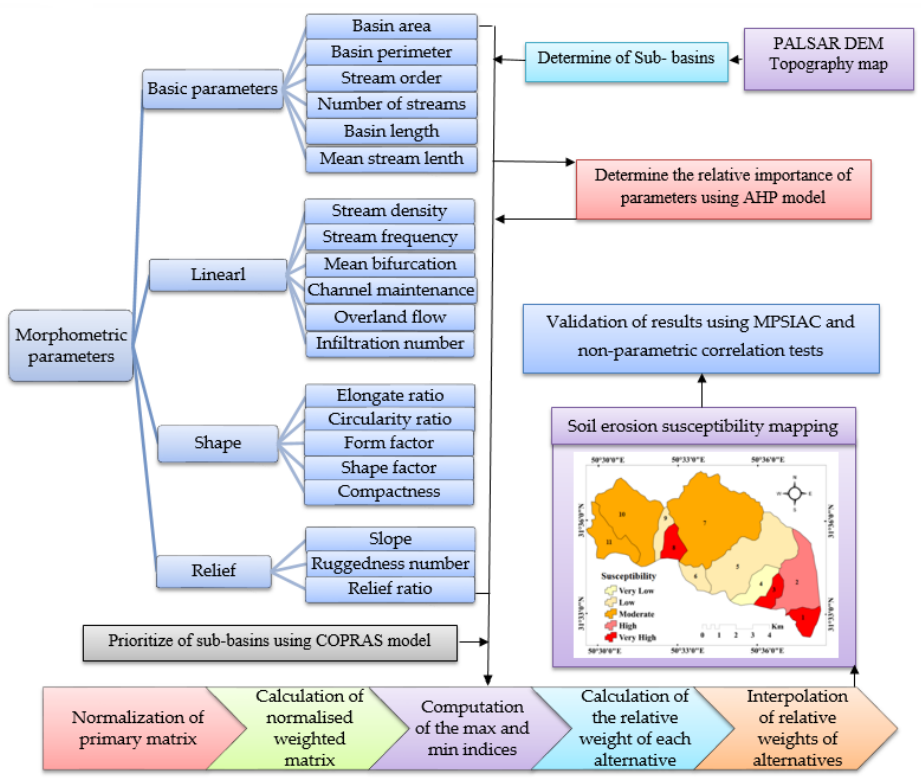
Figure 2. Flowchart of research in the study area. Table 1. Computation of basic, linear, shape, and relief morphometric